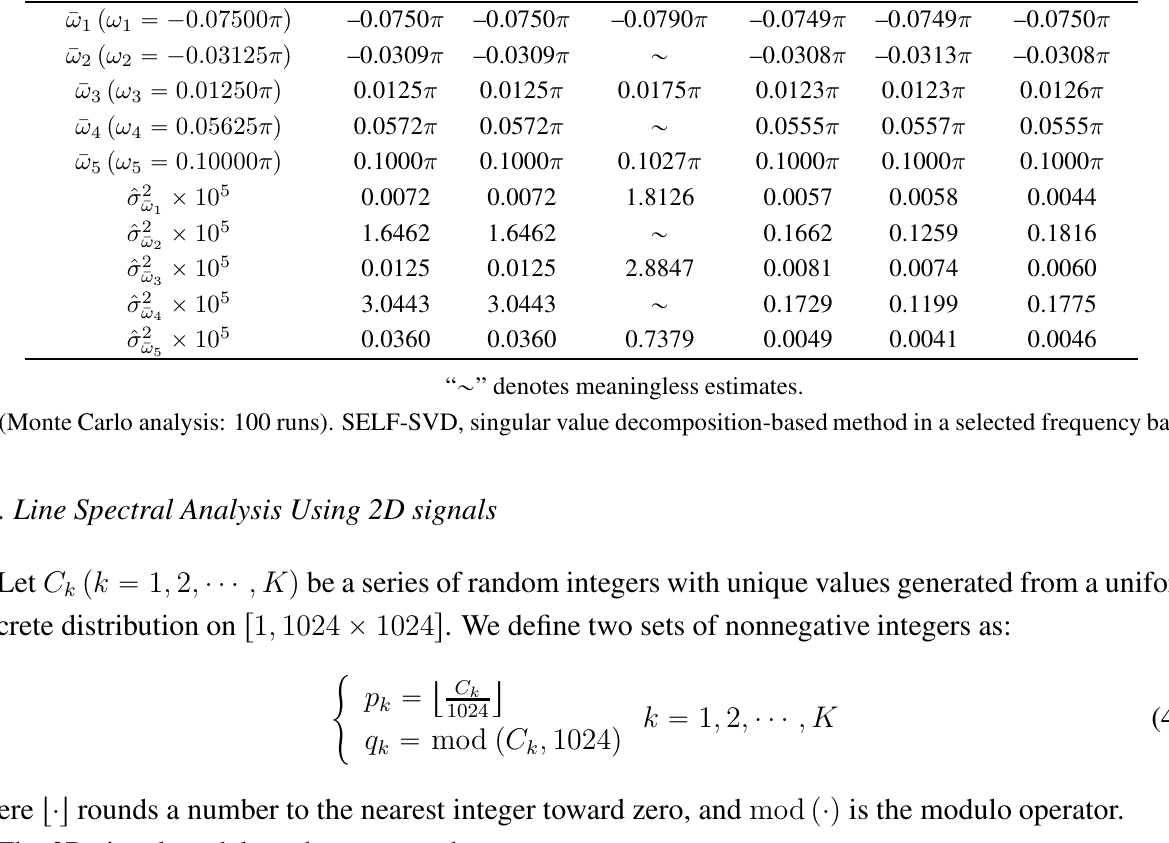
Table 1. Comparison of frequency estimation in full-band and sub-bands. Means and MSEs Full-band of Estimating